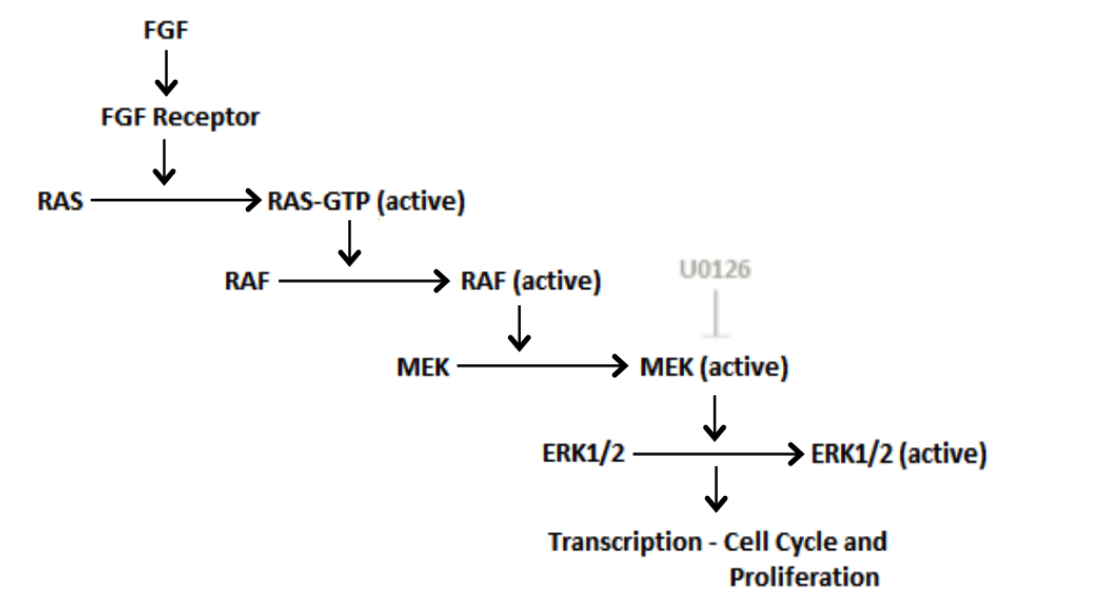
Figure 1. Fibroblast Growth Factor Receptor Cellular Signalling